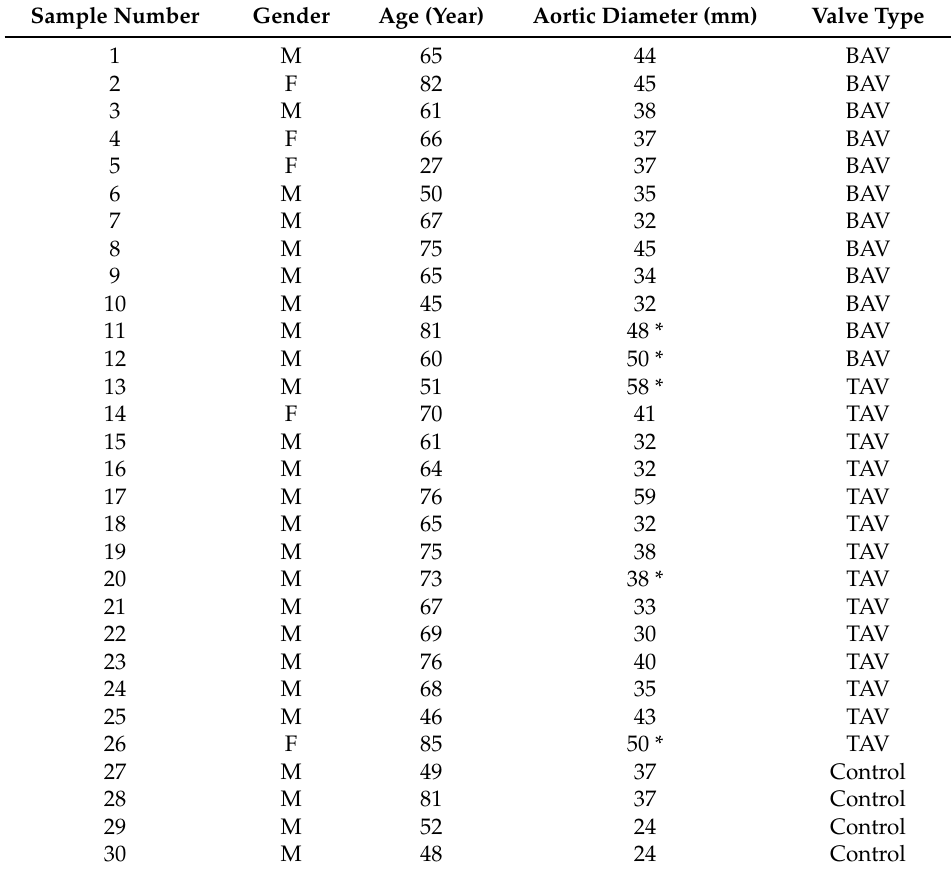
Table 1. The characteristics of patients’ population including control aortas ( n = 4) and aneurysmal aortas categorized into the bicuspid (BAV) ( n = 12) and tricuspid aortic valves (TAV) ( n = 14) tissue